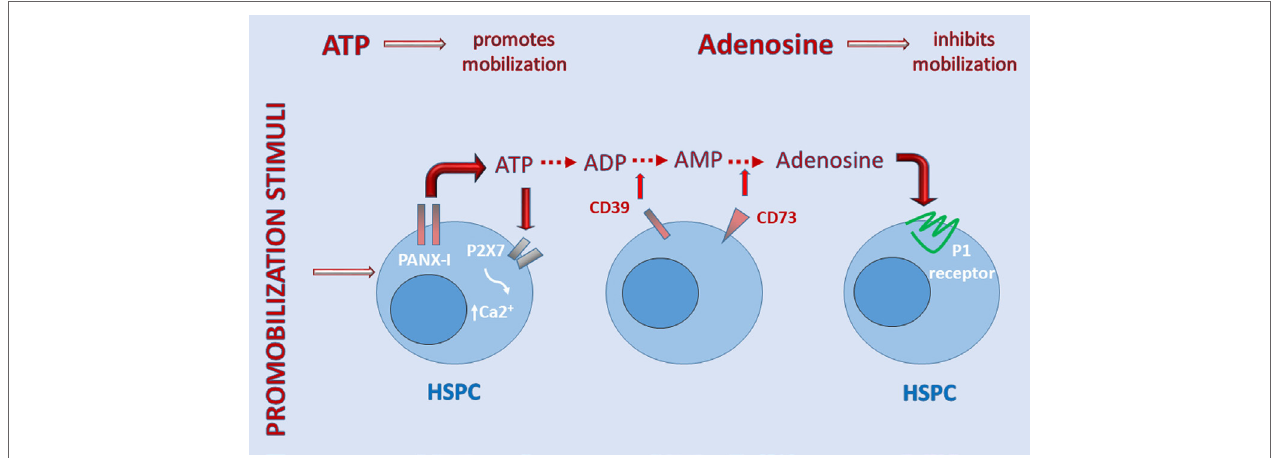
FiGURe 2 | A self-limiting purinergic signaling mechanism in the induction of sterile inflammation in bone marrow (BM). Adenosine triphosphate (ATP), which is abundantly released from cells via pannexin channels as a danger-associated molecular pattern (DAMP), is also processed in the extracellular space by several ectonucelotidases, including cell-surface-expressed CD39 and CD73, and these are crucial to generating extracellular adenosine. While ATP promotes sterile inflammation in the BM microenvironment and mobilization of hematopoietic stem/progenitor cells (HSPCs), adenosine has the opposite effect. Inhibitors of ectonuclotidases facilitate sterile inflammation in BM and egress of HSPCs. By contrast, inhibitors of adenosine receptors are expected to inhibit this